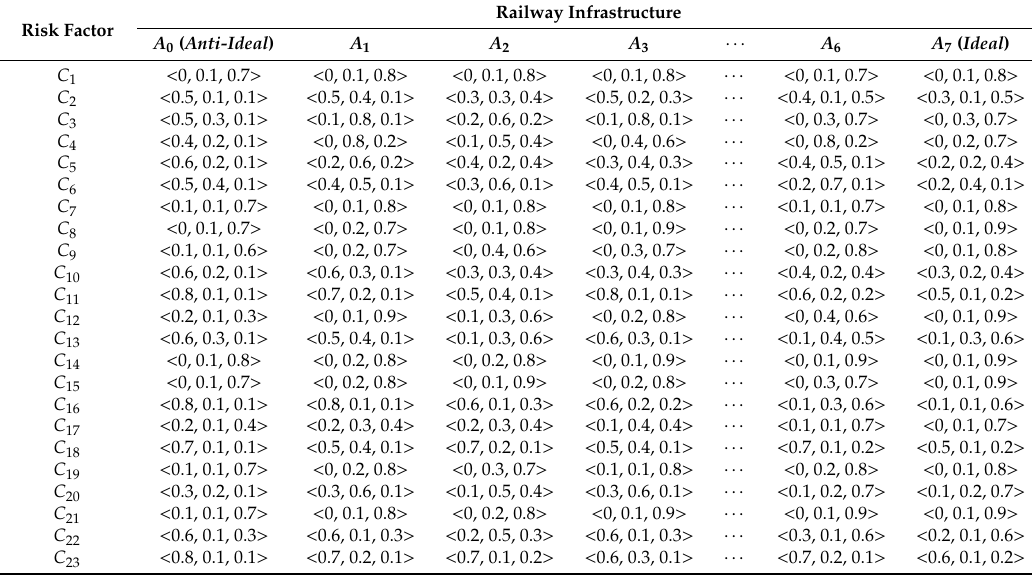
Table 10. The picture fuzzy extended evaluation matrix.